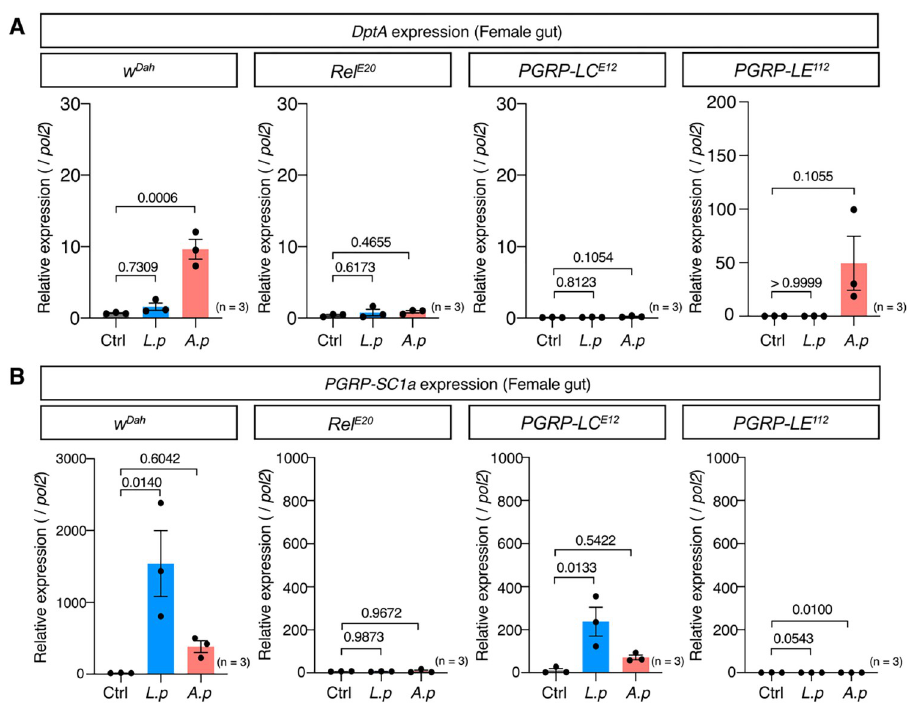
Fig 5. Distinct receptor PGRPs regulate different Imd target genes in gut. (A)(B) Quantitative RT–PCR of the genes DptA (A) and PGRP-SC1a (B) in female w Dah , Rel E20 , PGRP-LC E12 , and PGRP-LE 112 fly guts after 24 hours of BacD. For the statistics, ANOVA with Holm-Sˇı´da´k’s multiple comparison was used. The control diet followed the same procedure for BacD but it has only MRS broth in place of bacterial isolates, resulted in the antibiotics-contained diet. Sample sizes (n) and P values are in each